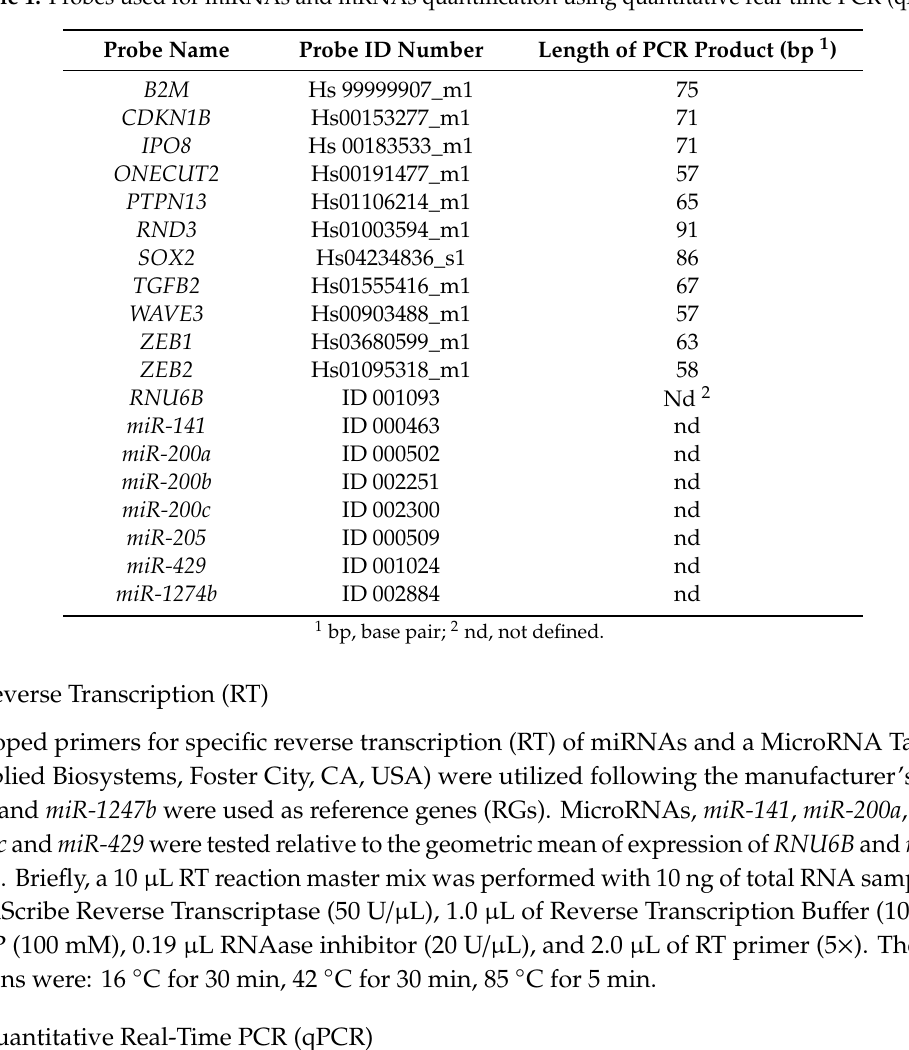
Table 1. Probes used for miRNAs and mRNAs quantification using quantitative real-time PCR